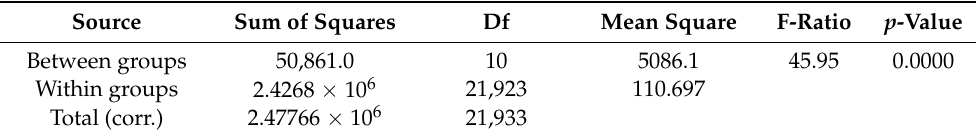
tion of the PTII WQA. Source Sum of Squares Df Mean Square p -Value Between groups 50,861.0 Within